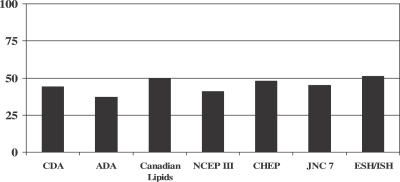
Percentage of Recommendations Citing RCTs That Were Based on High-Quality Evidence in Each GuidelineLegend and references: ADA, American Diabetes Association [11]; Canadian Lipids, the Canadian Working Group on Hypercholesterolemia and Other Dyslipidemias [13]; CDA, Canadian Diabetes Association [10]; CHEP, the Canadian Hypertension Education Program [16,17]; ESH/ISH, European Society of Hypertension/International Society of Hypertension [19]; JNC 7, Joint National Committee seventh report [18]; NCEP III, Third Report of the National Cholesterol Education Program [14].